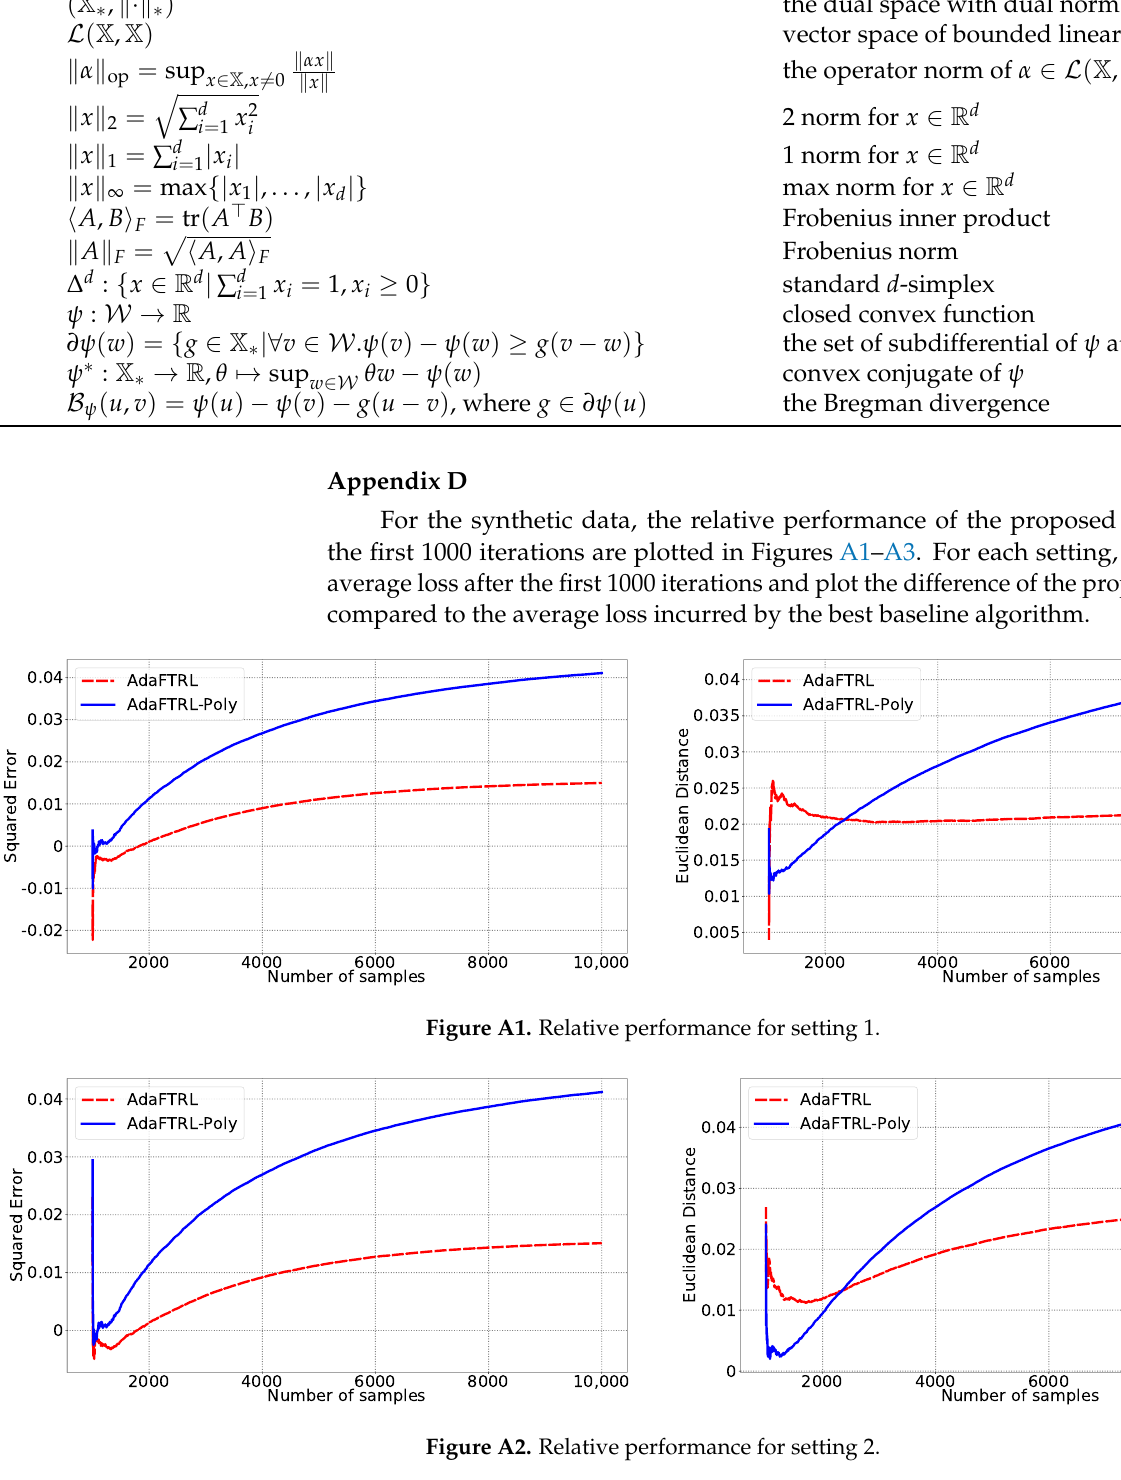
Figure A2. Relative performance for setting